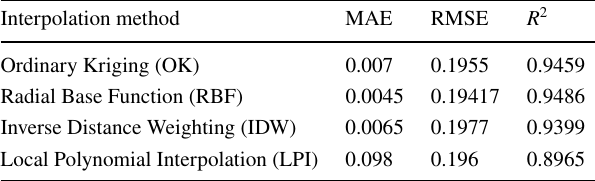
Table 3 Adebra NSR summary of interpolation accuracy